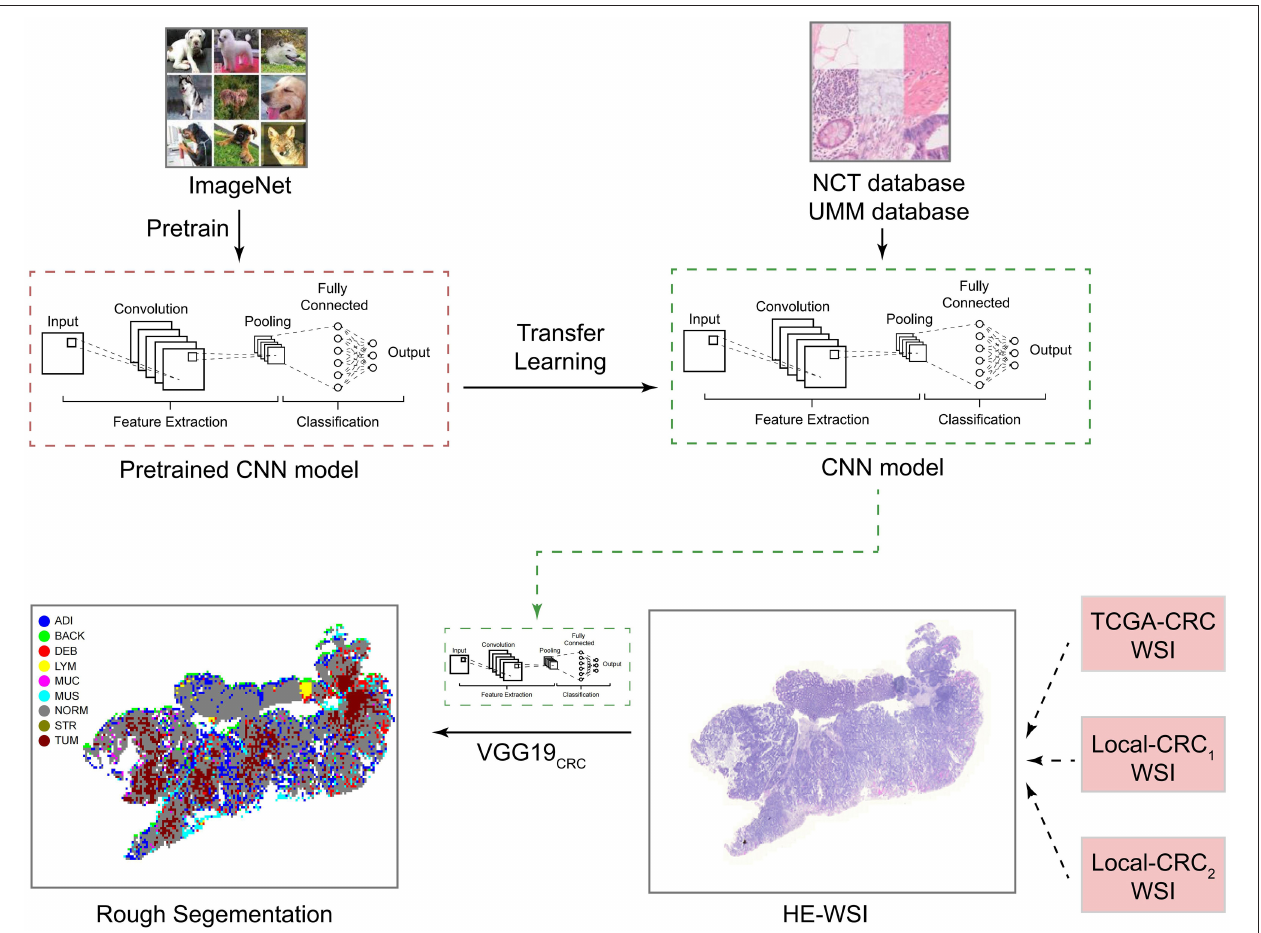
FIGURE 1 | Study design for the development and application of the CNN model. CNN, convolutional neural network; H&E, hematoxylin and eosin; WSI, whole-slide image; ADI, adipose; BAC, background; DEB, debris; LYM, lymphocyte aggregates; MUC, mucus; MUS, muscle; NOR, normal mucosa; STR, stroma; and TUM, tumor